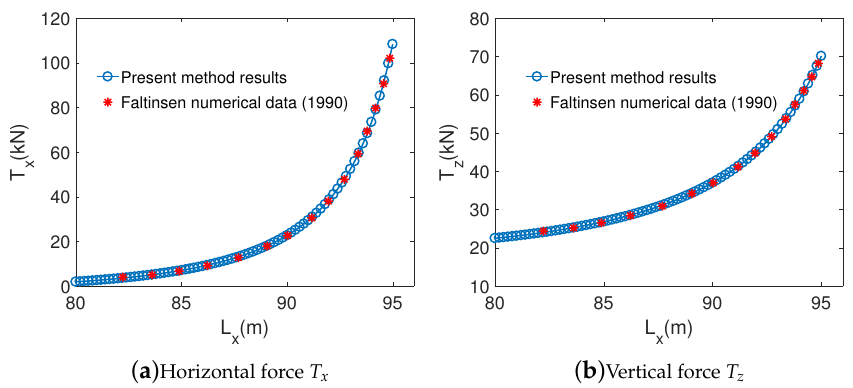
Figure 4. Comparison of mooring line stiffness with respect to horizontal force T x ( a ) and vertical force T z ( b ) between proposed numerical method and numerical data of